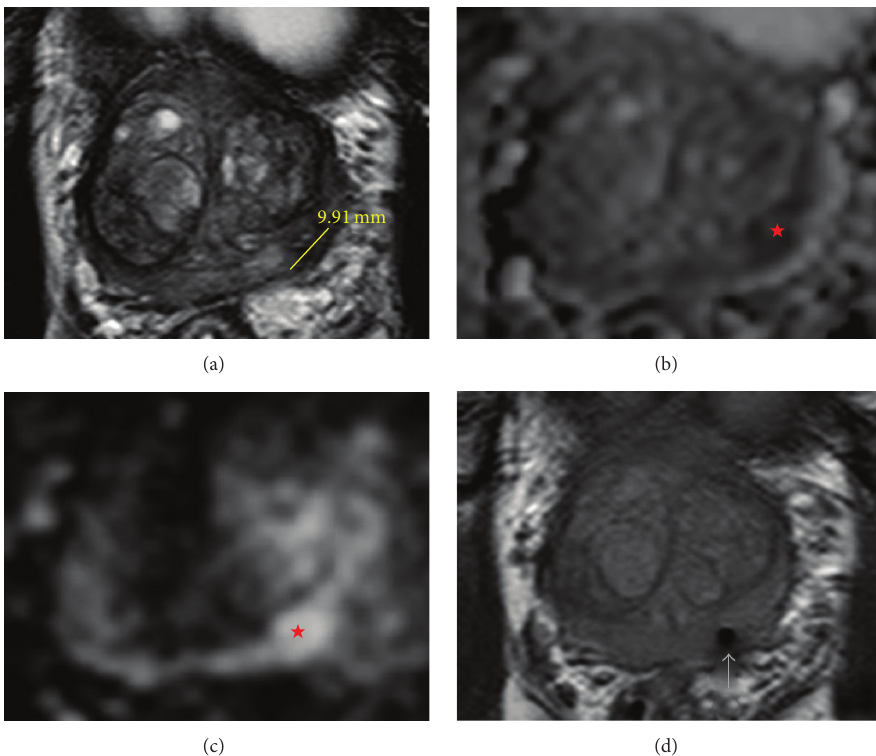
Figure 1: (a) Magnetic resonance T2 weighted axial image of the prostate tumor (left base of the peripheral zone) with line indicating a tumor diameter of 9.19 mm. (b) Magnetic resonance diffusion weighted with apparent diffusion (ADC) mapping; lesion indicated by red star. (c) Magnetic resonance diffusion weighted with B2000 axial image of the prostate tumor (left base of the peripheral zone) indicated by the red star. (d) Magnetic resonance T2 weighted axial image confirming accurate needle placement in lesion prior to taking biopsy (arrow pointing to needle